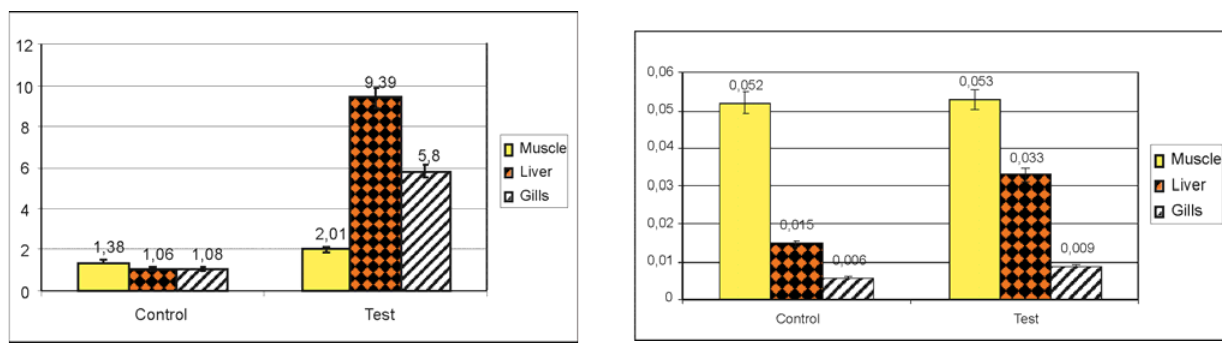
Fig. 7. Lead concentration (mg/kg) in tissues of rainbow trout